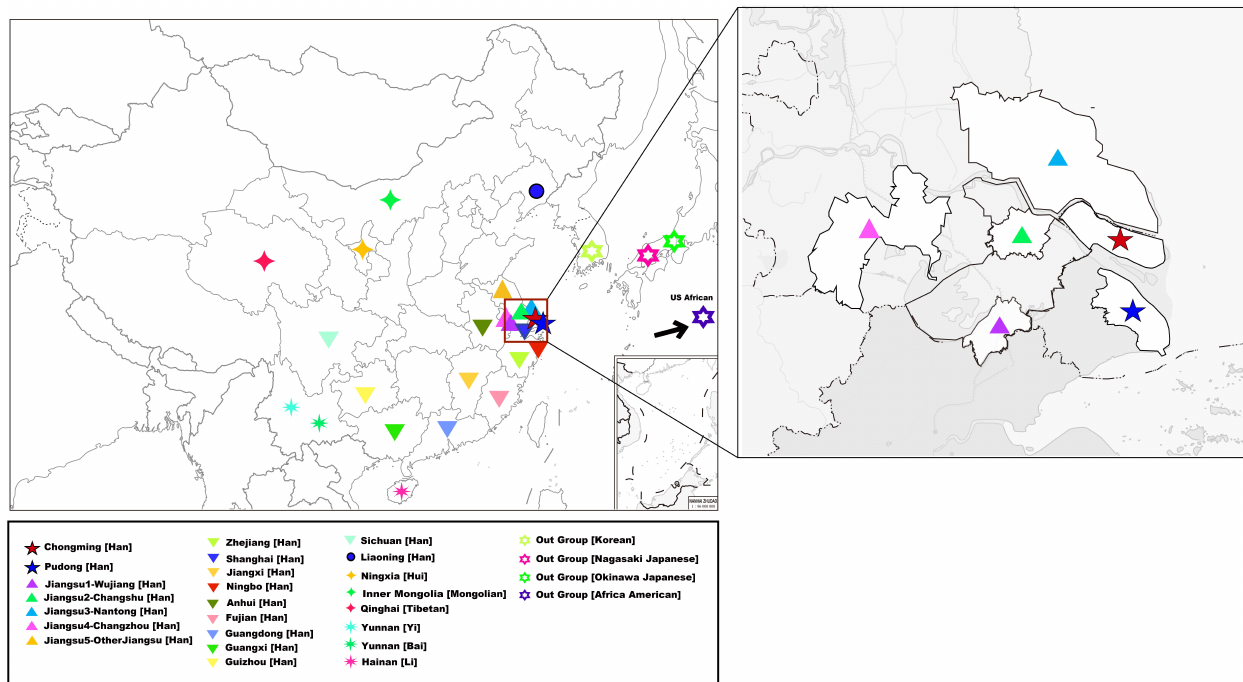
Figure 1. Geographical positions of the Pudong Han and Chongming Han populations with other 26reference populations in this